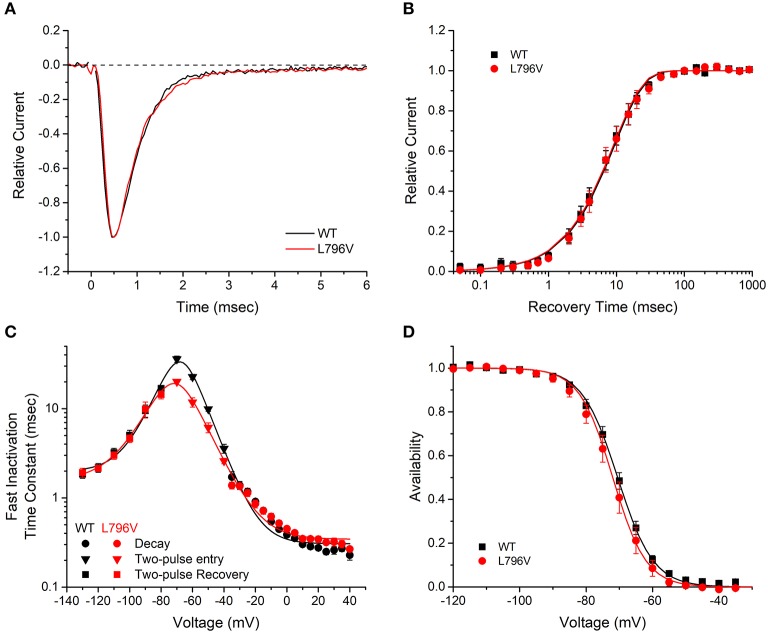
Fast inactivation is not affected by the L796V mutation. (A) Sodium current decay kinetics are indistinguishable for WT and L796V channels. Representative current traces elicited at −10 mV have been normalized by peak amplitude. (B) Recovery from fast inactivation is identical for WT and L796V channels. Data show the time course for the recovery of peak current amplitude at a holding potential of −90 mV, after channels were inactivated with a conditioning pulse of 30 ms at −10 mV. Symbols show means for WT (n = 8) and L796V (n = 5). (C) Summary plot of the time constants for entry or recovery from fast inactivation shows identical kinetics for WT and L796V channels. Three separate protocols were used to measure inactivation kinetics, depending on the voltage range, as described in section Methods and Materials. Symbols show means from WT (n = 16) and L796V (n = 10). (D) The steady-state voltage dependence of fast inactivation was indistinguishable for WT (n = 15) and L796V (n = 10) channels. Plot shows relative amplitude for the peak sodium current elicited by a depolarization to −10 mV after a 300 ms conditioning pulse at the indicated voltage (abscissa).